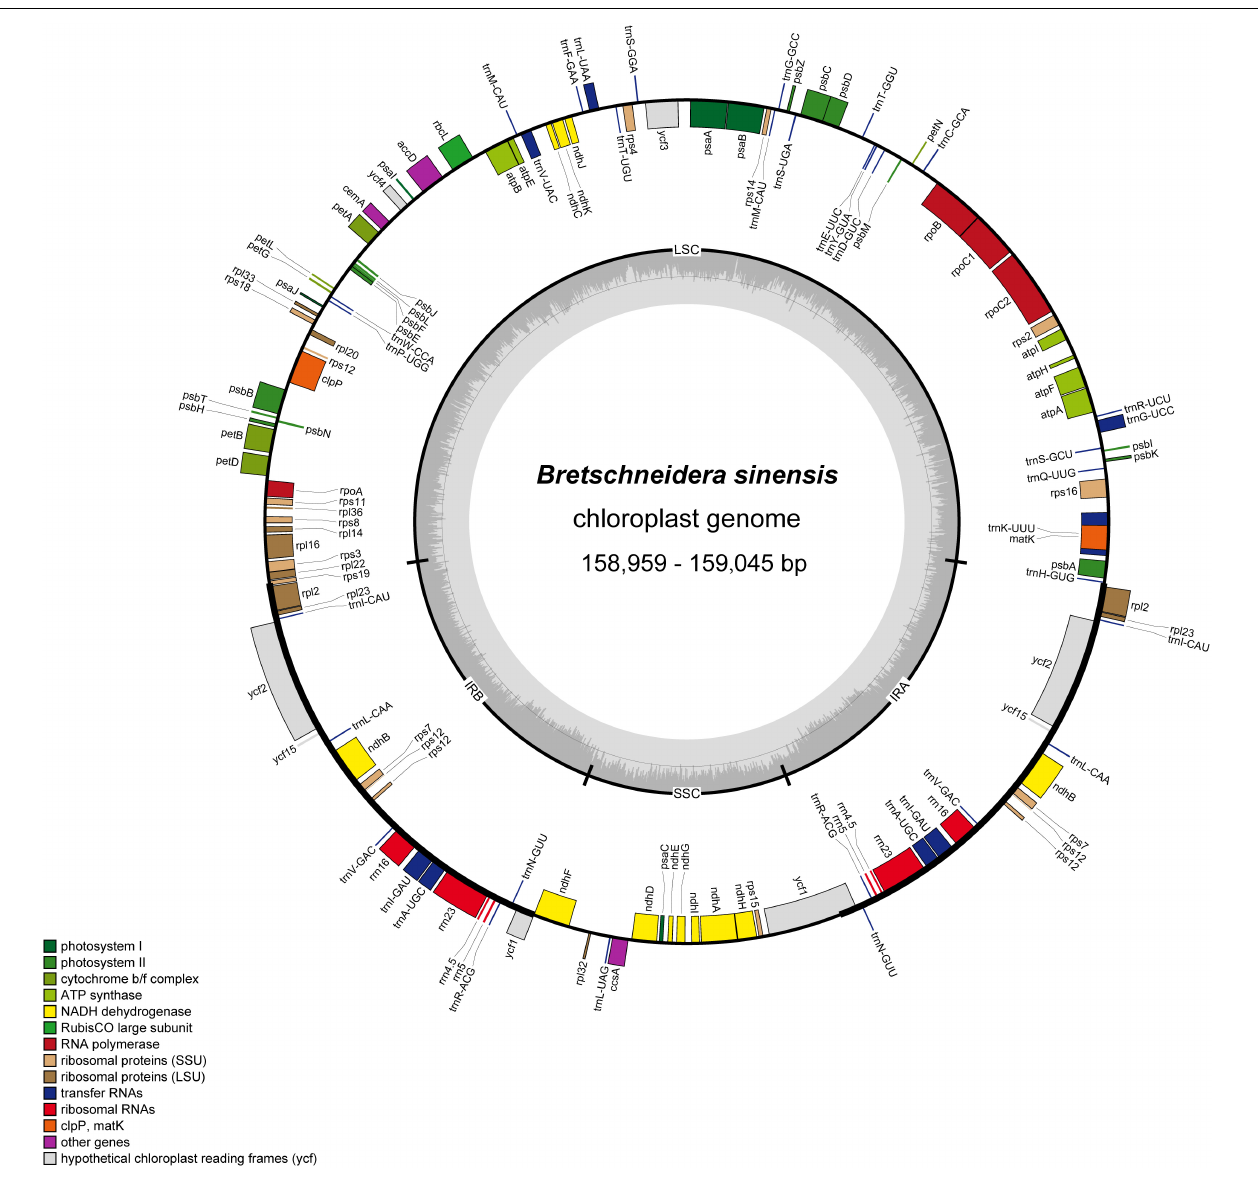
FIGURE 2 | Gene maps of the B. sinensis chloroplast genomes. Genes on the inside of the large circle are transcribed clockwise, and those on the outside are transcribed counterclockwise. The genes are color-coded based on their functions. The dashed area represents the GC composition of the chloroplast genome.